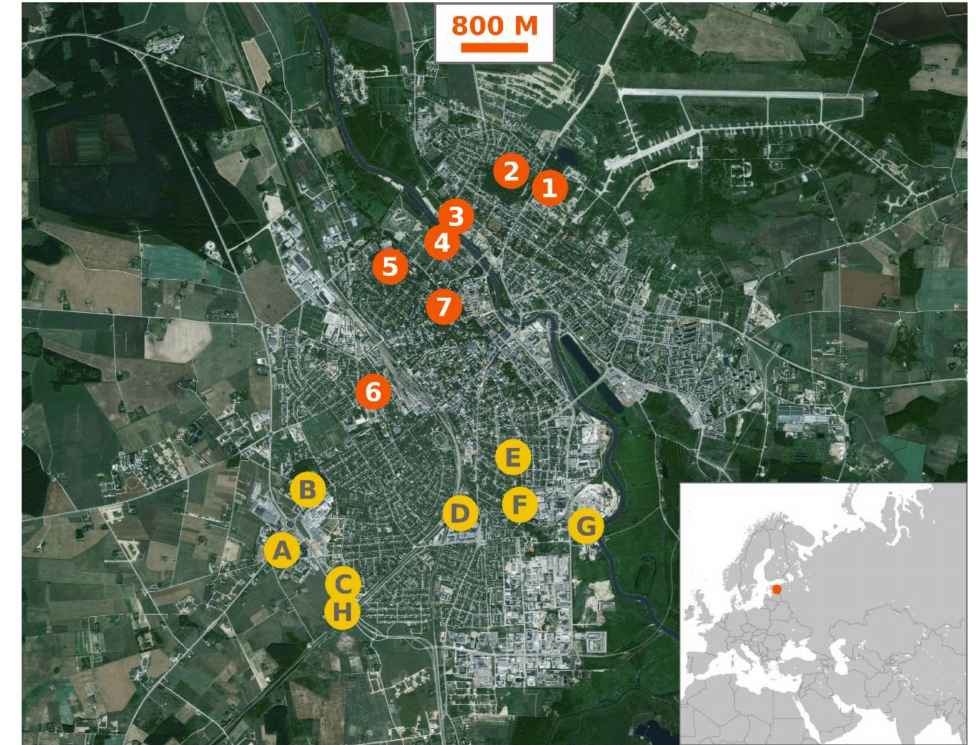
Figure 1. Map showing the collection sites in Tartu and the location of Estonia. Sites 1, 2, 3, 4, 5 and 6 were used in 2013, 2016 and 2017. Site 7 was included in the study in 2016 and 2017. Sites A, B, C, D, E, F, G and H were added in 2017. Base map of Tartu: Estonian Land